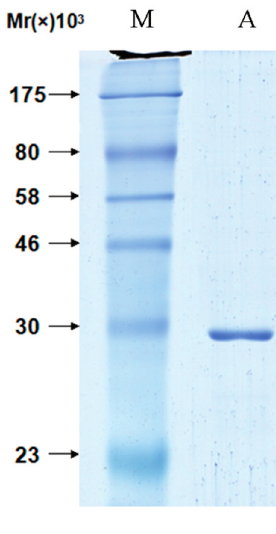
Figure 4. Apyrase protein could bind to VirG protein